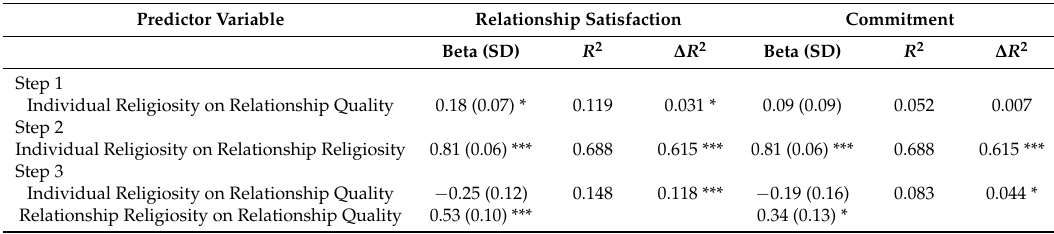
Table 3. Mediation analyses for individual religiosity for relationship quality ( N = 119).